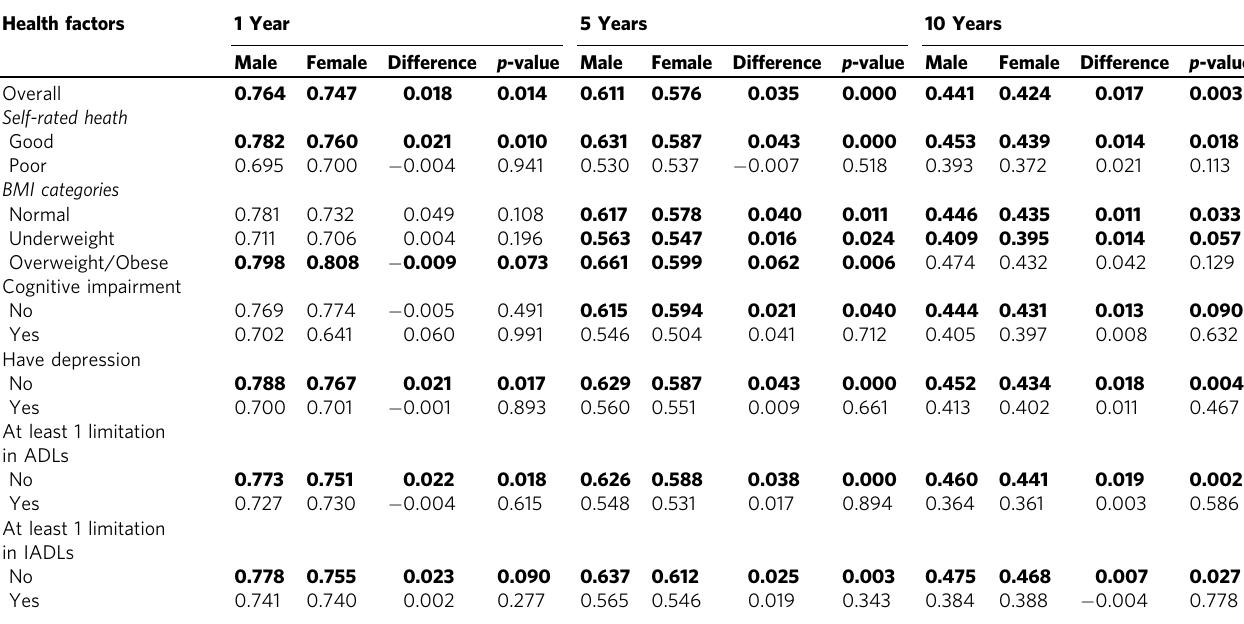
Table 2 Gender differences in the subjective probability of own survival according to various health-related factors, LASI, 2017 –